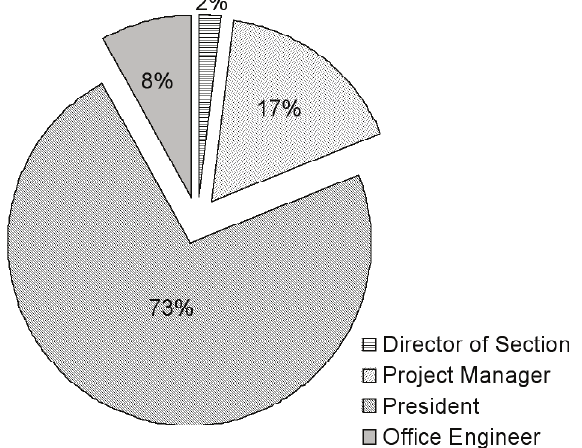
Figure 3: Distribution of respondent’s position